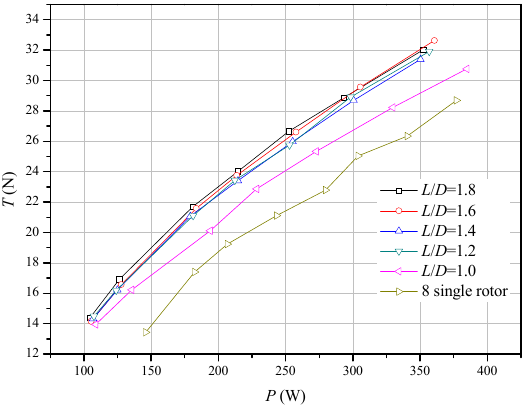
Figure 3. Thrust and power consumption variation.